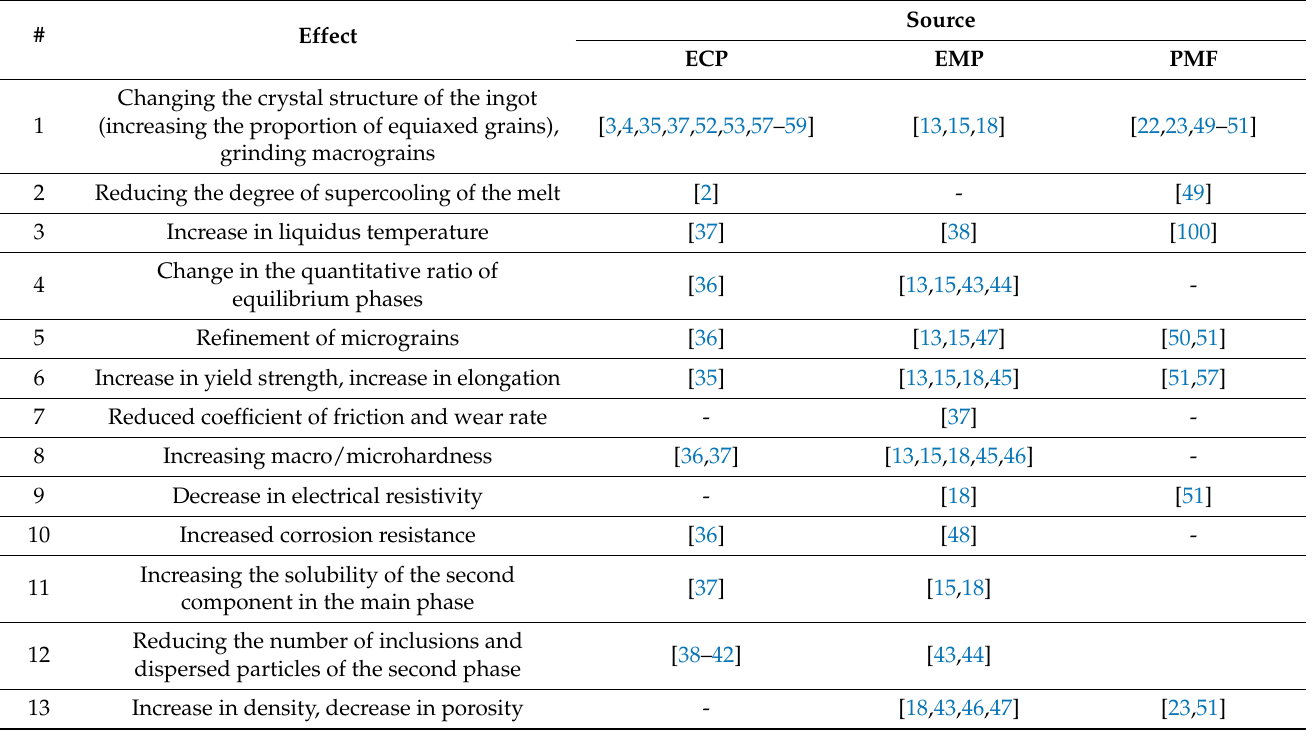
Table 9. Effects of impulse